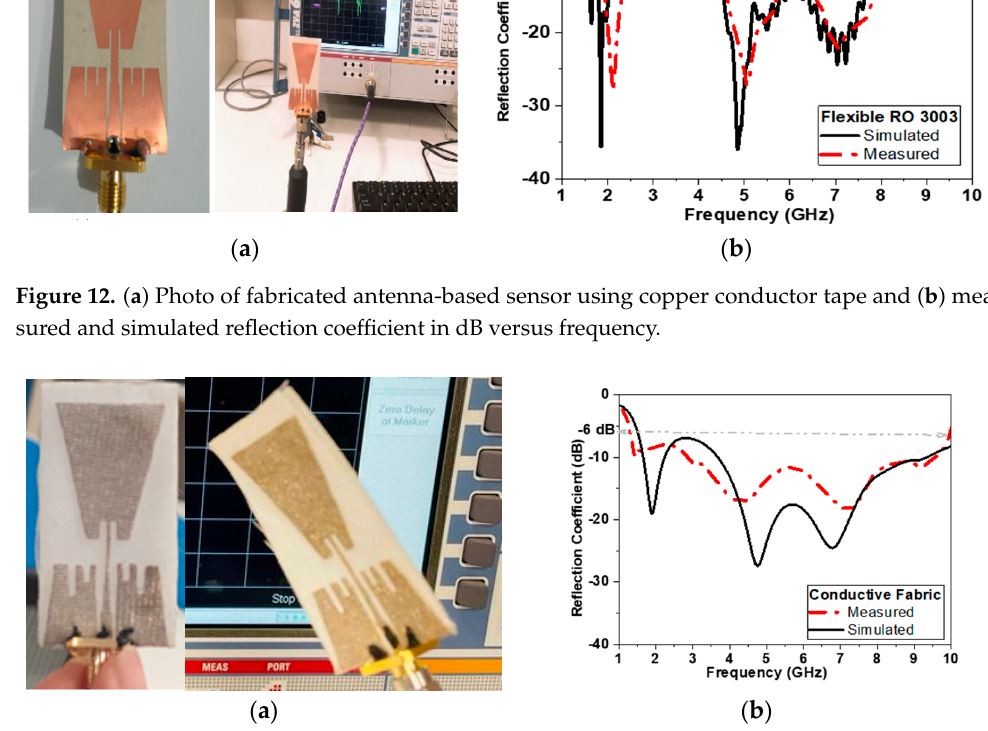
Figure 13. ( a ) Photo of fabricated antenna-based sensor using fabric conductor and ( b ) measured and simulated reflection coefficient in dB versus frequency.